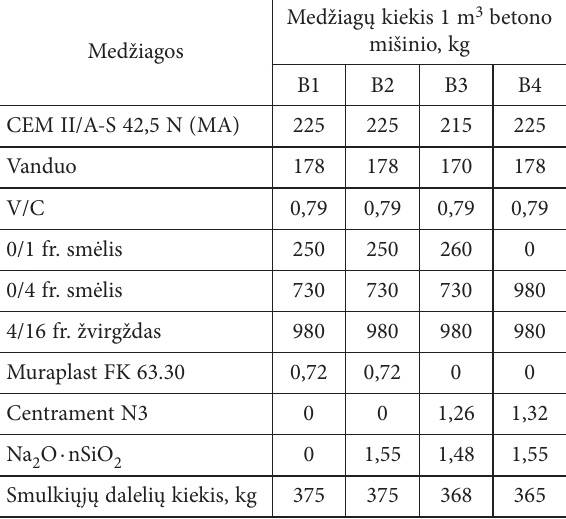
Table 4. The compositions of concrete mixtures